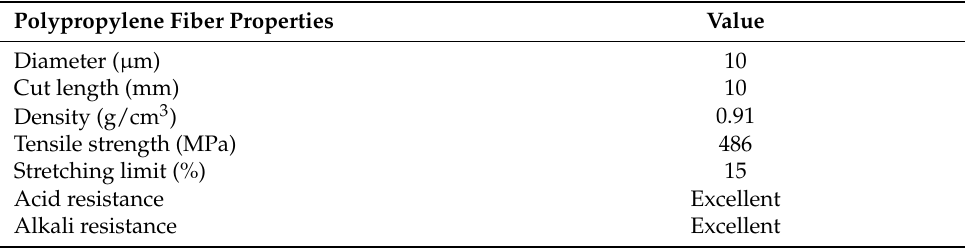
Table 3. Physical and mechanical properties of polypropylene